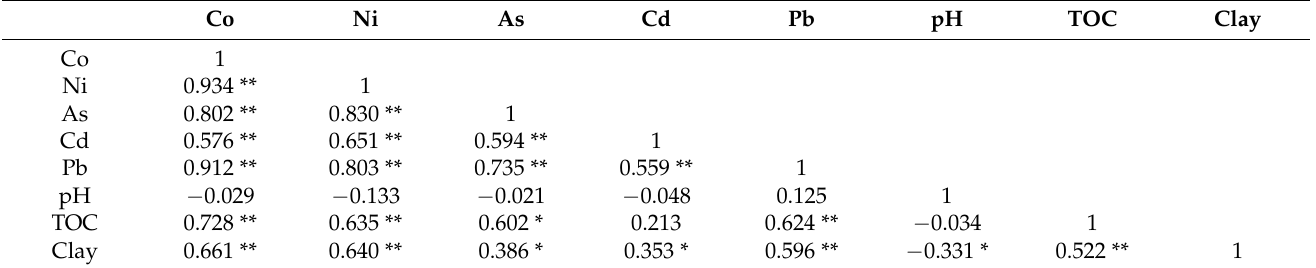
Table 3. Spearman’s correlation coefficient with a two-tailed test between the parameters of sediments in S. alterniflora swamps of the Yellow River